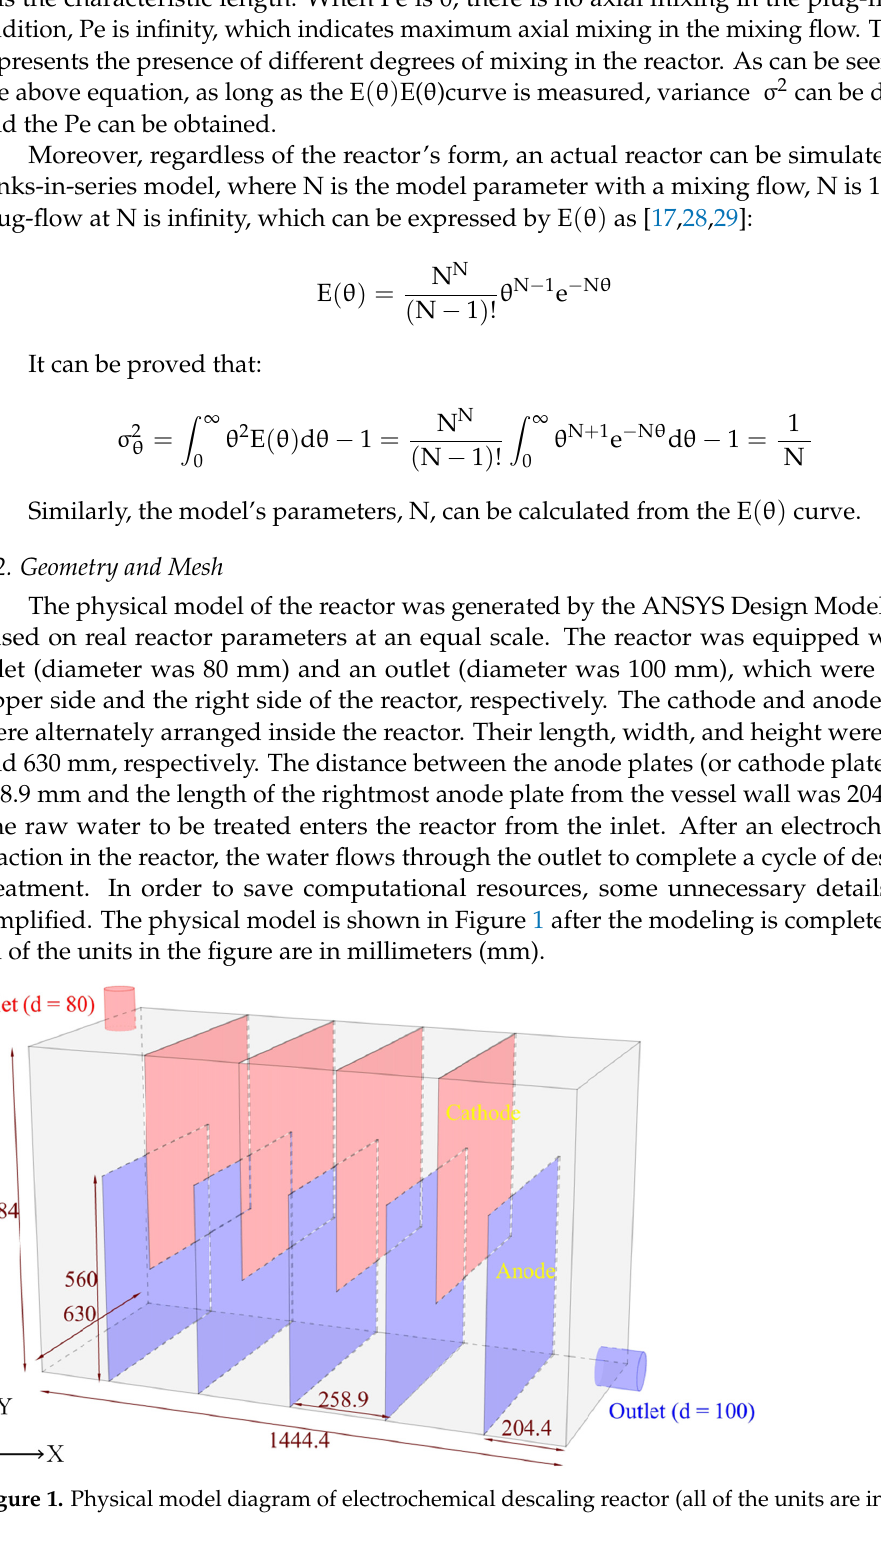
calculation cost, and calculation speed. In this paper, the mesh was created in ANSYS Meshing [31]. Due to the friction between the fluid and the pipeline, there were large ve- locity gradients at the inlet and outlet. In addition, we set boundary layer meshes for the inlet and outlet to ensure the accuracy of the calculation results. Due to the large curvature at the inlet and outlet, and the narrow area in the model at the pole plate, we selected a smaller mesh size for these areas to improve the calculation accuracy. The other areas of the model were set with a larger mesh size to improve the computational speed and save costs. The completed grid is shown in Figure 2, and the total number of cells in the grid is 12302903. A combination of a tetrahedral grid and a hexahedral grid was used to divide the grid, and the average quality of the grid was above 0.81. The skewness was less than 0.2, which ensured the accuracy of the calculation results.